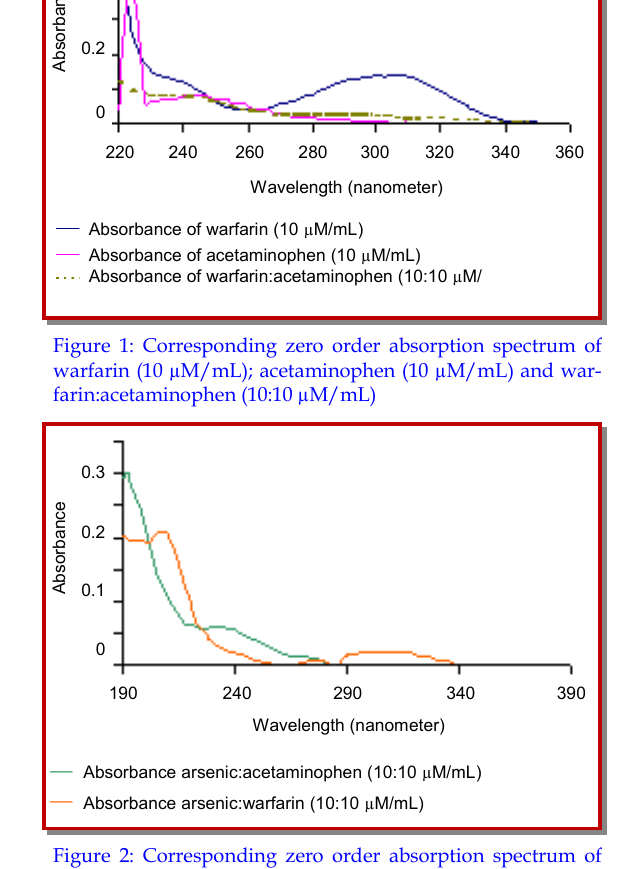
Figure 2: Corresponding zero order absorption spectrum of arsenic:acetaminophen (10:10 µM/mL) and